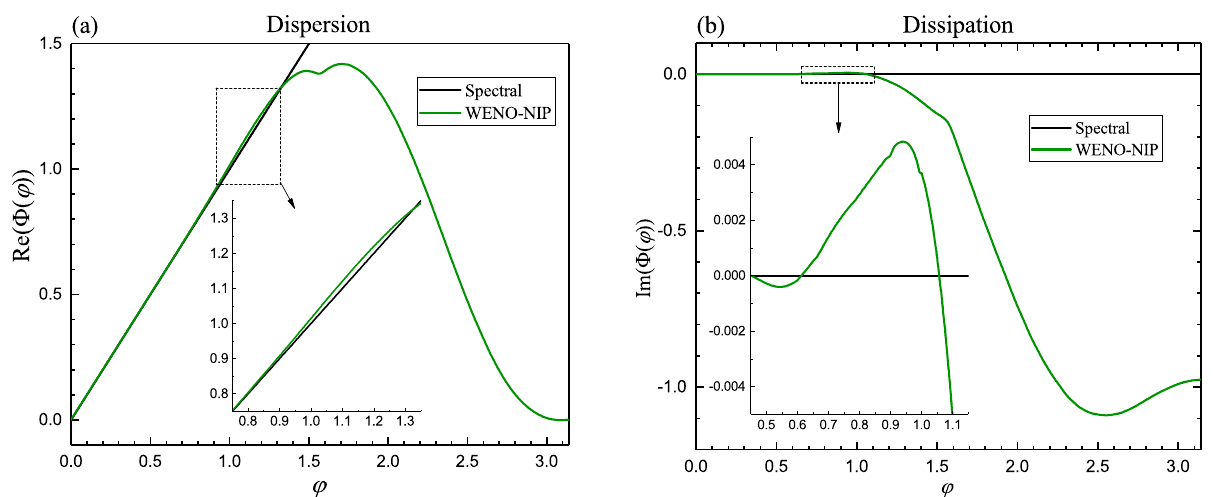
Figure 1. ( a ) The dispersion properties of WENO-NIP. ( b ) The dissipation properties of